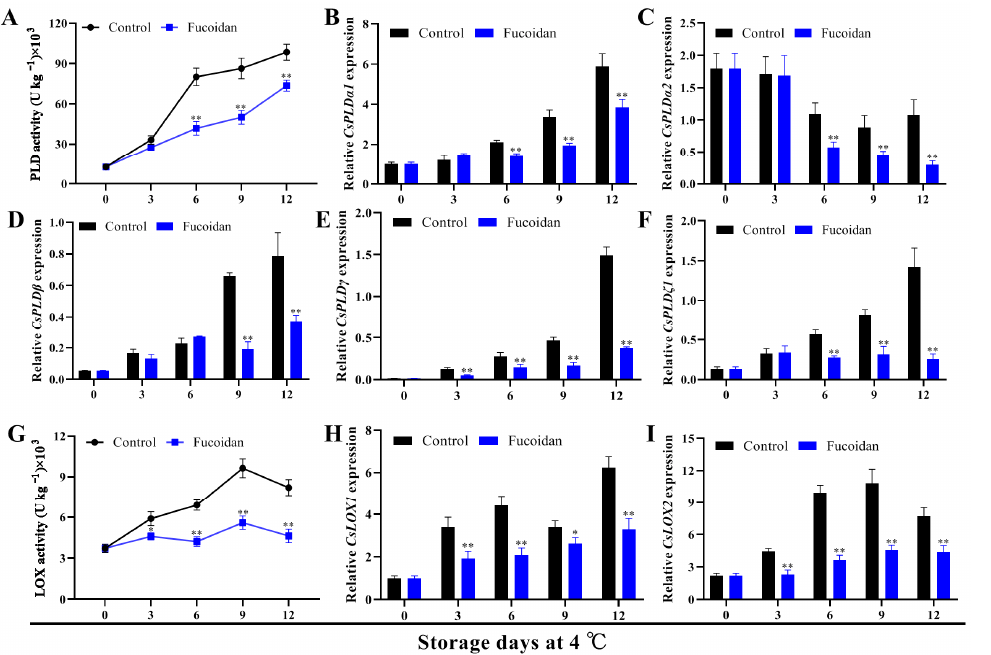
Figure 5. PLD activity ( A ) and gene expression of CsPLD α 1 ( B ), CsPLD α 2 ( C ), CsPLD β ( D ), CsPLD γ ( E ), CsPLD ζ 1 ( F ), LOX activity ( G ), CsLOX1 ( H ), and CsLOX2 ( I ) in fucoidan-treated and control cucumber fruit during storage at 4 °C. Values are marked as mean ± standard deviation (SD) of three replicates. Symbols * and ** express significant differences at p < 0.05 and p < 0.01 between fucoidan-treated and control fruit, respectively.